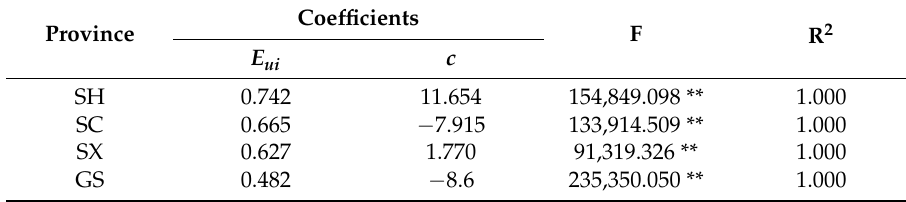
Table 4. Fitting results for the function for the cost of electricity consumption.